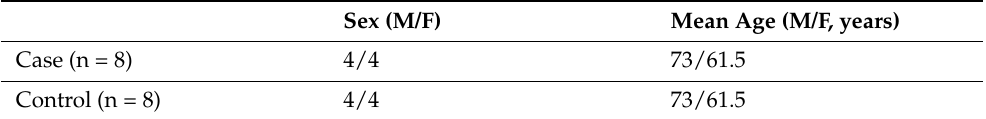
Table 1. Demographic